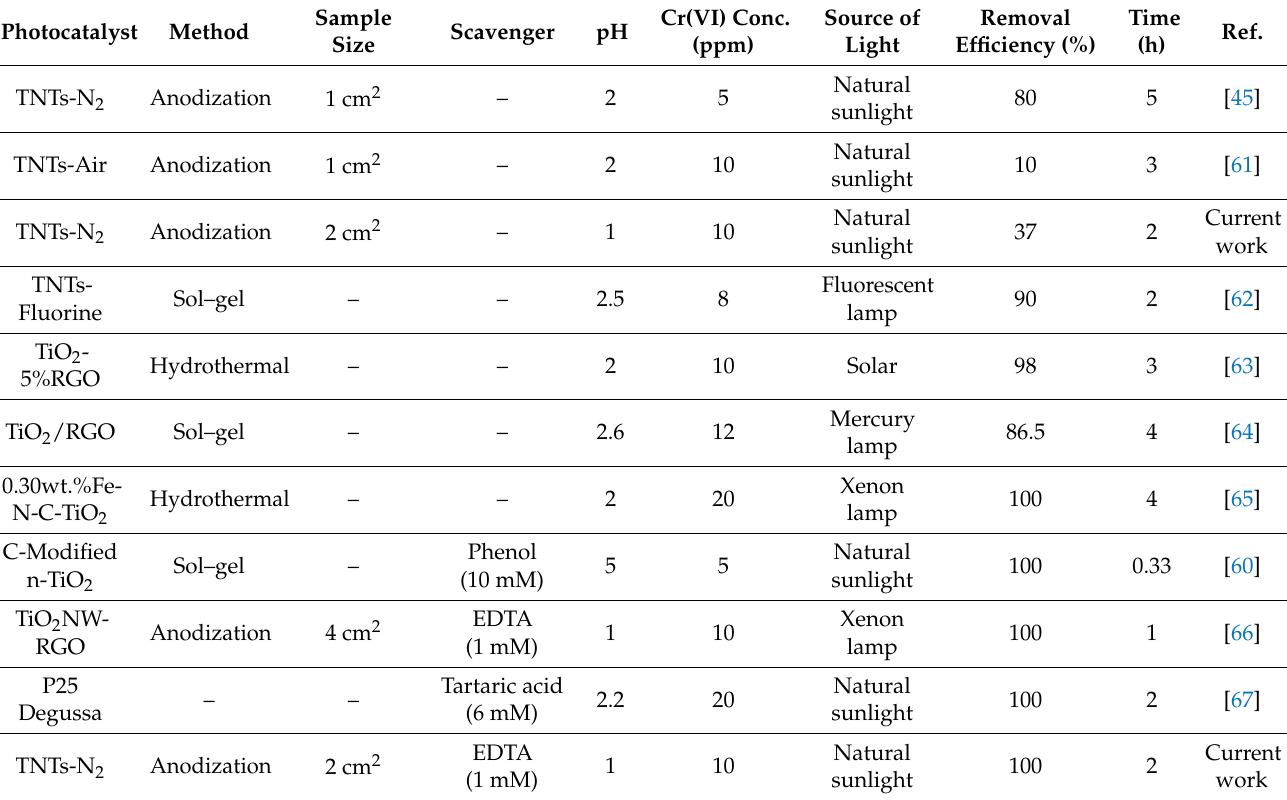
Table 2. Comparison of obtained Cr(VI) reduction efficiency with recent studies under UV–Vis light irradiation (RGO = reduced graphene oxide; C = carbon; N 2 =